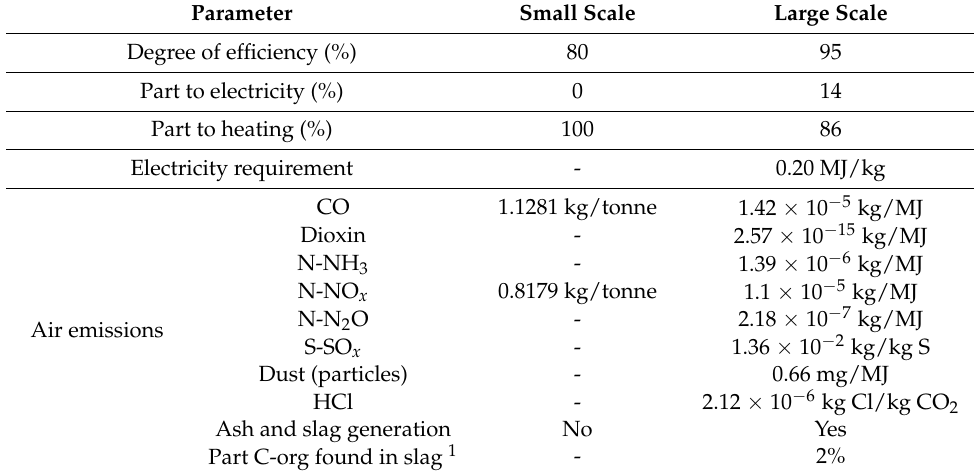
Table A5. Process data on incineration. Data on small scale from [13] and large scale from [30].